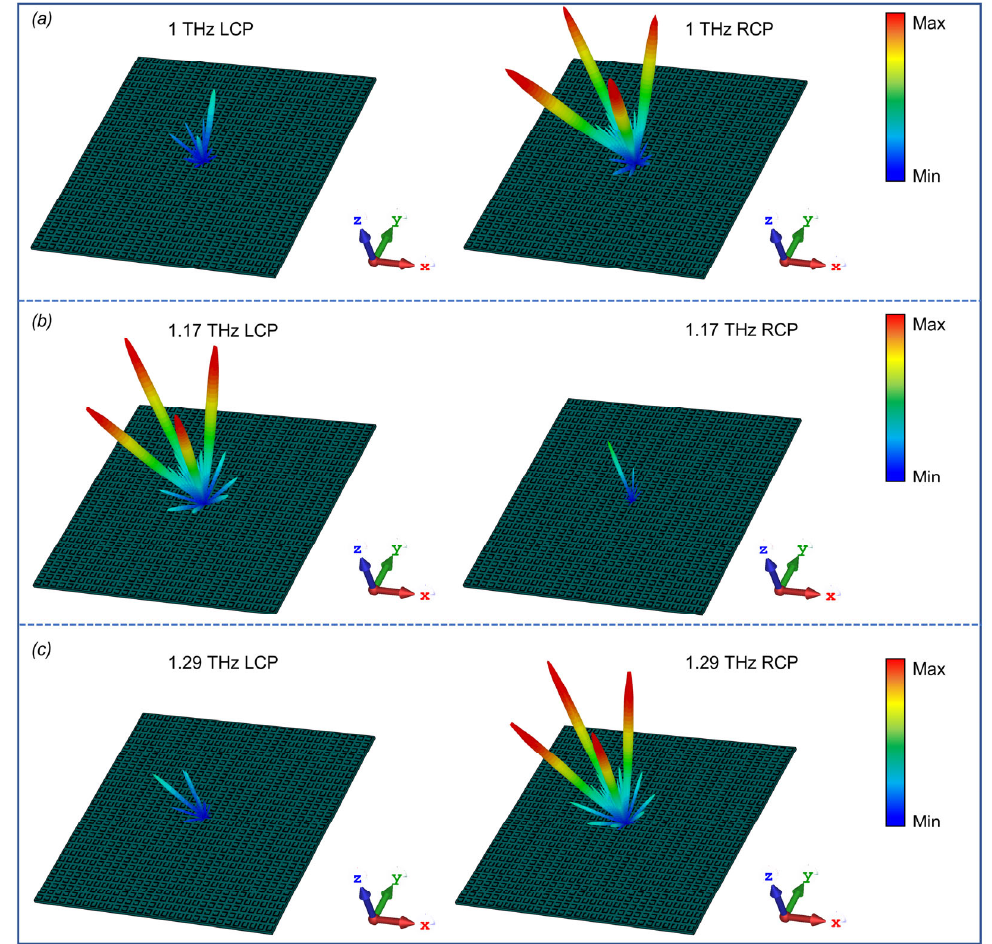
Figure 7. The simulated 3D far-field results for the SSA four-beam splitting metasurface array. ( a ) The array under the normal incidence of LCP/RCP at 1 THz; ( b ) The array under the normal incidence of LCP/RCP at 1.17 THz; ( c ) The array under the normal incidence of LCP/RCP at 1.29 THz.